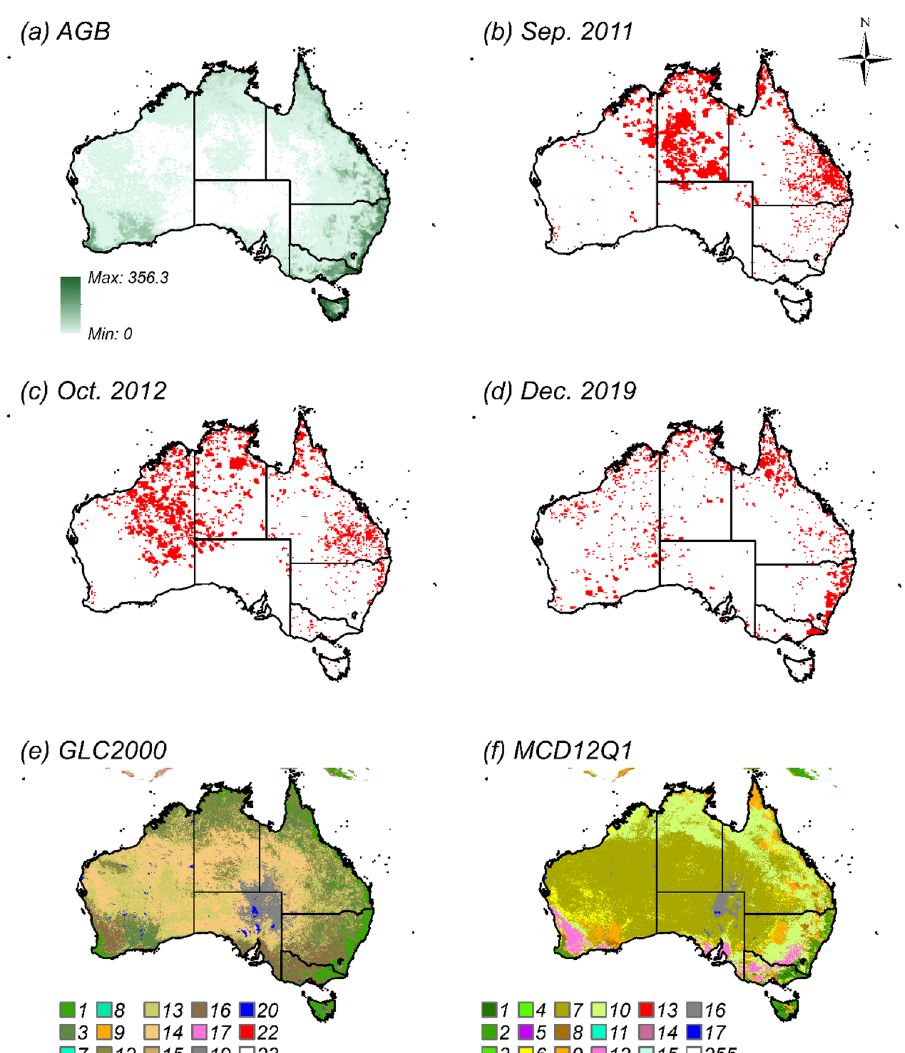
Figure 3. Distribution maps of AGB (Mg ha −1 ), burnt area, and LC. AGB map ( a ) was created by averaging the GEOCARBON and Globbiomass maps. Burnt area maps based on LC–M represent: ( b ) September 2011, ( c ) October 2012, and ( d ) December 2019. LC maps for 2018 at 500 m spatial resolution are: ( e ) GLC2000 and ( f ) MCD12Q1. The numbers in ( e ) and ( f ) indicate the category values for LC maps (Table S1). The grid size for maps from ( a – f ) was 20 km × 20 km. Maps were created with ArcGIS version 10.5 (https:// www. arcgis.